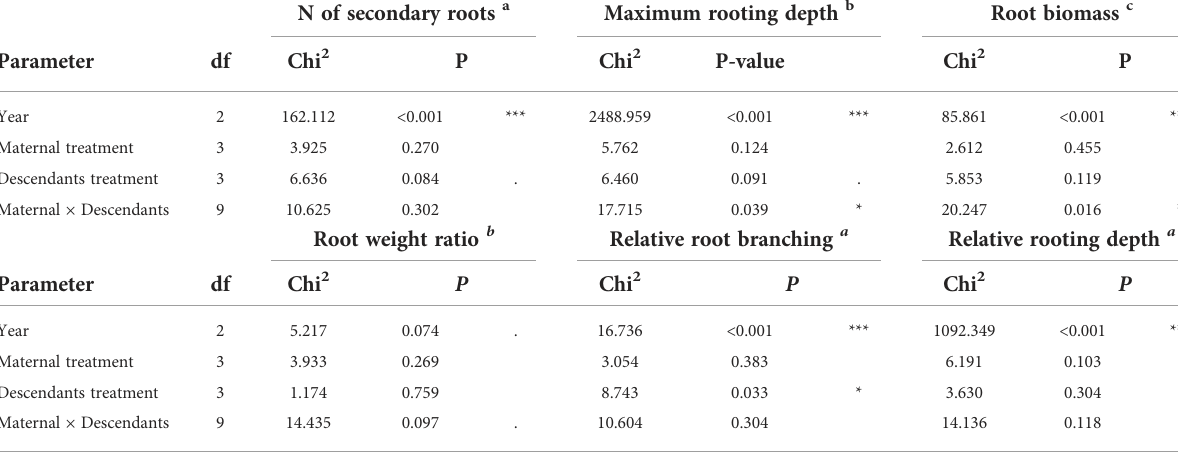
TABLE 2 Root transgenerational plasticity to precipitation predictability